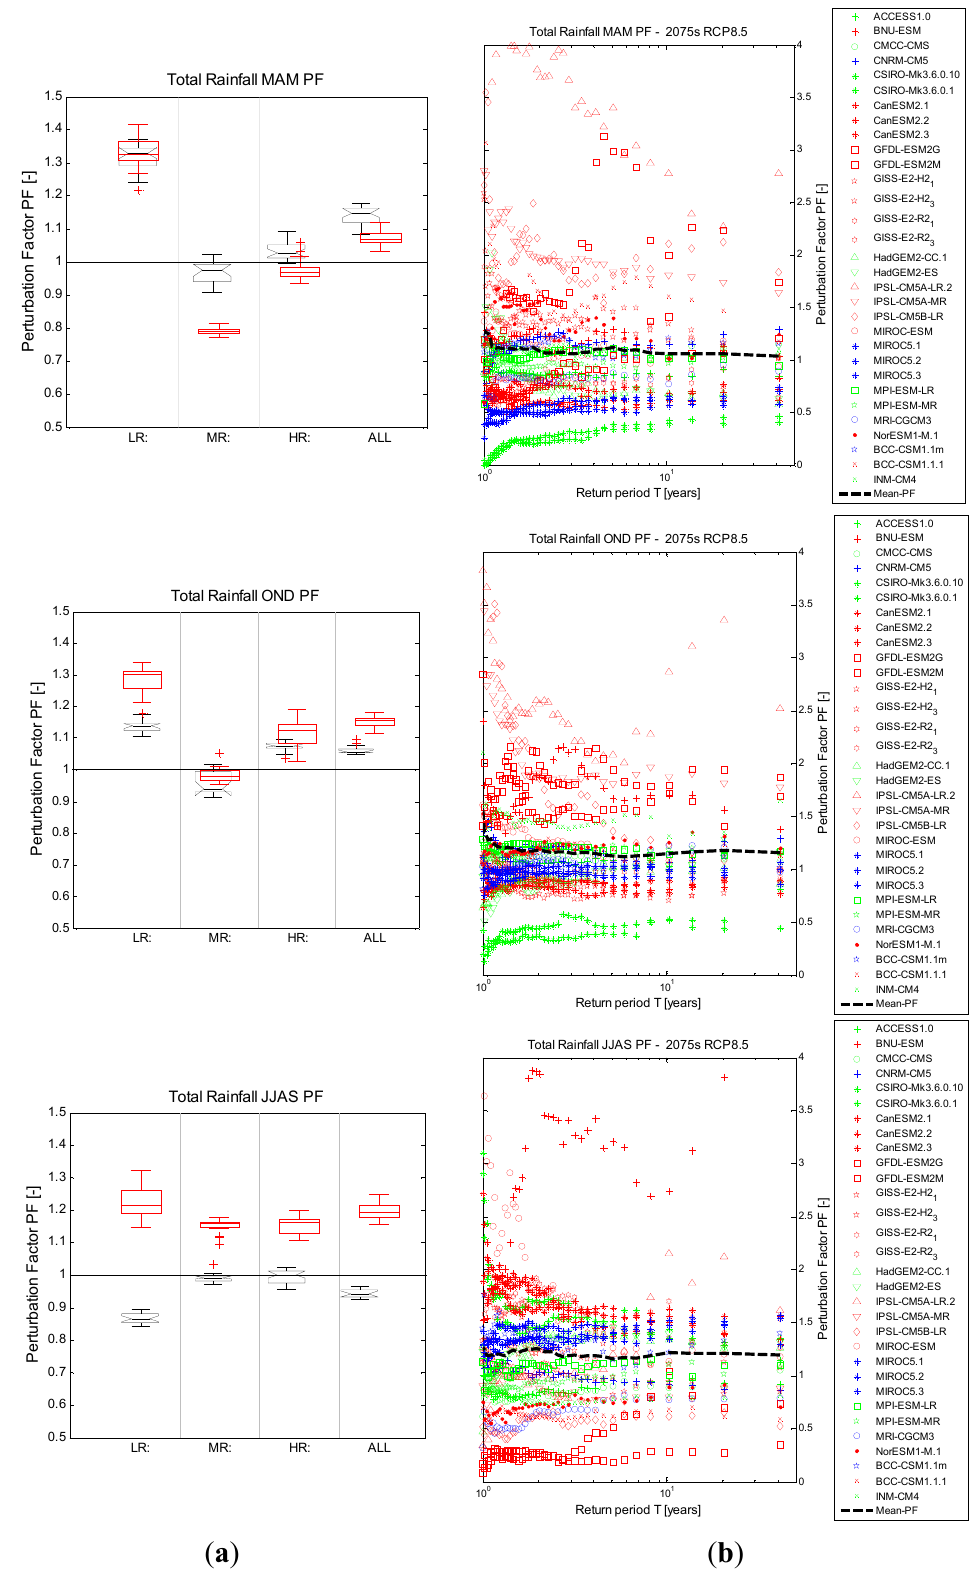
Figure 12. ( a ) Perturbation factors for total seasonal precipitation simulated by the different GCMs for the 2040s (notched) and 2075s, for RCP8.5; ( b ) Perturbation factors vs. return period for total seasonal precipitation simulated by the different GCMs in the 2075s for RCP8.5, Red = LR GCMs, Blue = HR GCMs and Green = MR